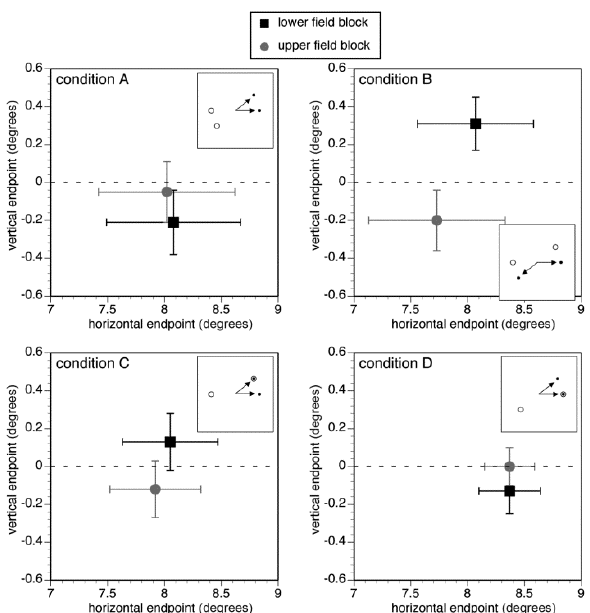
Figure 2. Results. Each graph plots the Cartesian (x,y) coordinates of the mean endpoint of horizontal saccades in each of the four conditions, from blocks in which the alternate trial was in the upper field and from blocks in which it was in the lower field. Error bars indicate one standard error. Note that conditions A and D have attractive biases (saccades in the lower field block are lower than those from the upper field block) while conditions B and C generate repulsive biases (saccades in the lower field block are higher than those from the upper field block). Insets illustrate the two trial types for